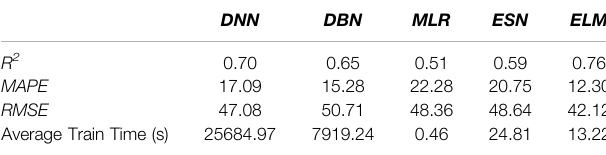
TABLE 9 | Mean performance indices of different algorithms.